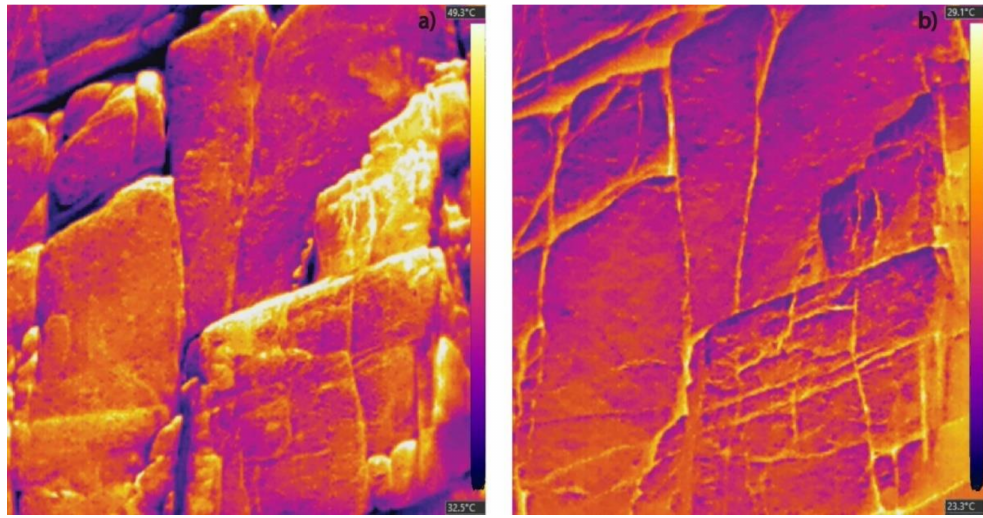
Figure 5. Thermograms recorded at ( a ) midday and ( b ) midnight where small fractures show less heat compared with larger